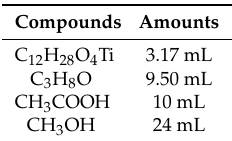
Table 3. Reagents for Synthesis 3.